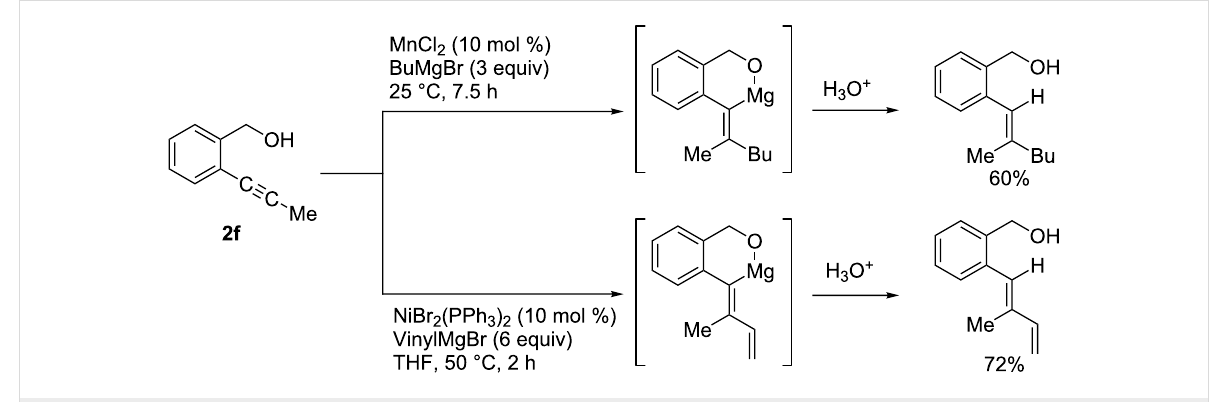
Scheme 10: Vinylation and alkylation of arylacetylene-bearing hydroxy group.